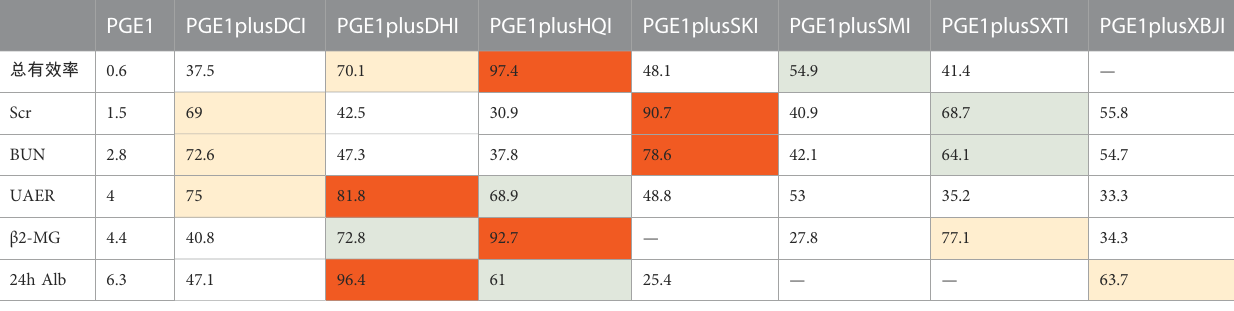
TABLE 4 Results of the surface under the cumulative ranking curve (SUCRA) (%). PGE1